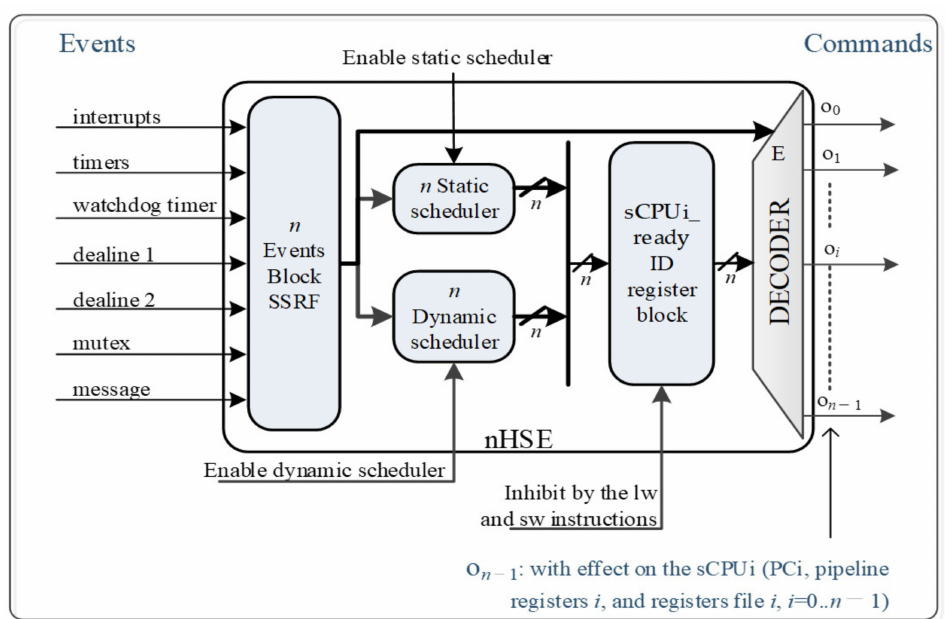
Figure 3. Architecture of the real-time hardware scheduler